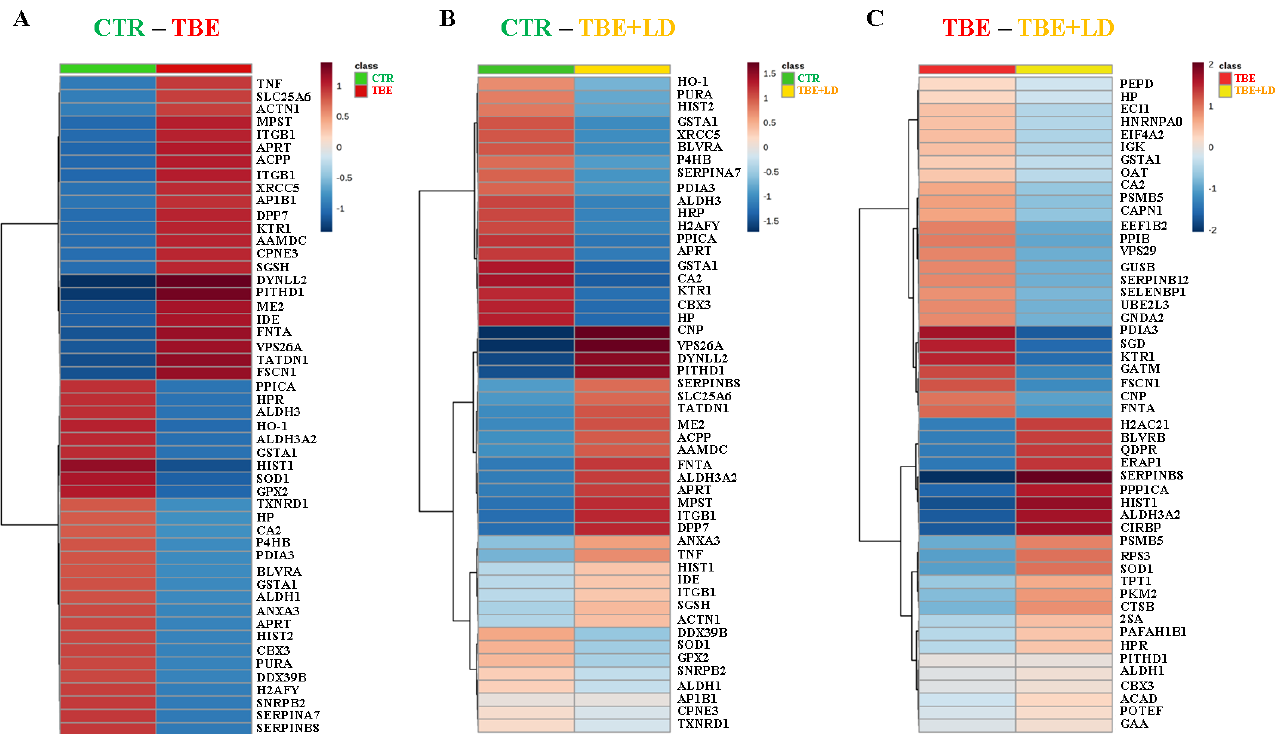
Figure 3. Heatmaps of top 50 proteins identified by ANOVA expressed in the plasma samples of the control group (CTR, n = 8), patients with tick-borne encephalitis (TBE, n = 16), and patients with TBE and co-infection (TBE+LD, n = 5). Heatmaps show the results when analyzed CTR with TBE ( A ); CTR with TBE+LD ( B ), and TBE with TBE+LD ( C ). Data showed the average protein intensity. The heatmaps with the intensity of proteins of the individual samples are included in the supplementary files (Supplementary File S4).